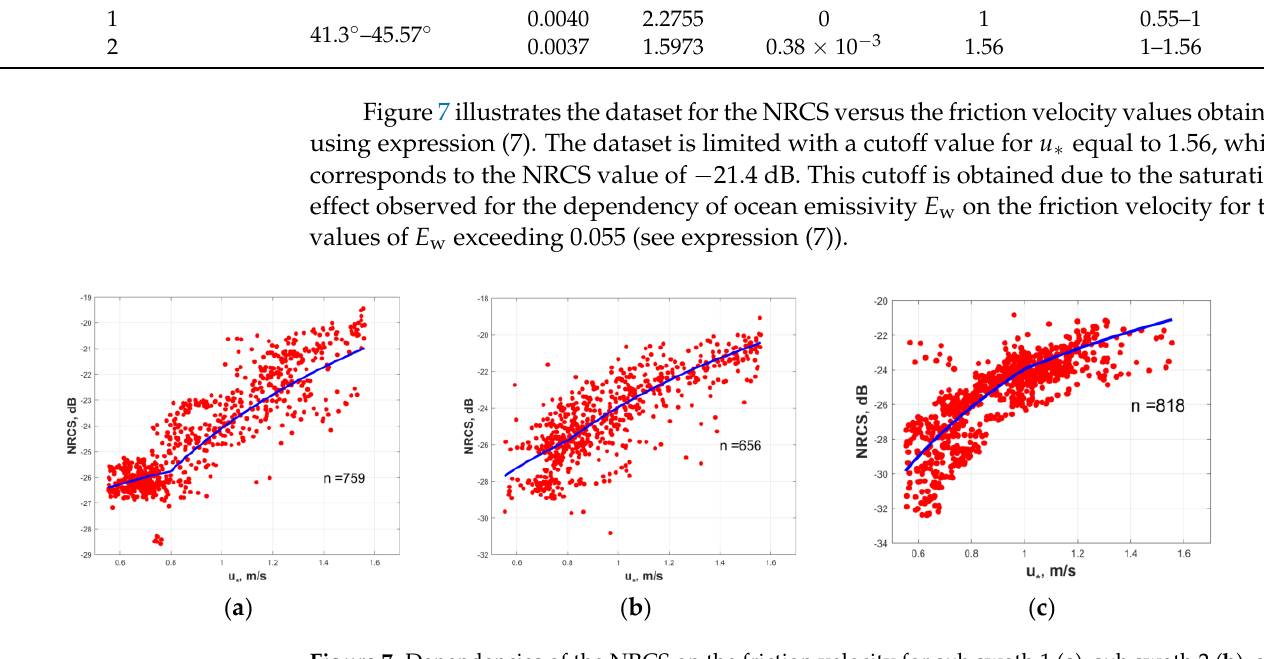
Figure 7. Dependencies of the NRCS on the friction velocity for sub swath 1 ( a ); sub swath 2 ( b ); and sub swath 3 ( c ). The blue curve represents the power approximation from Table 3. n corresponds to the number of data points used to construct the proposed GMF.